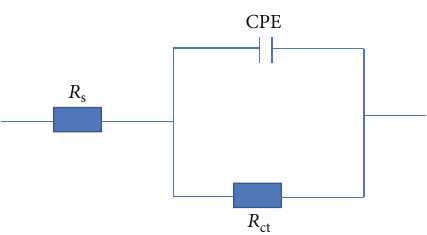
Figure 6: Equivalent circuit used for fitting the impedance data in 1M HCl solution.